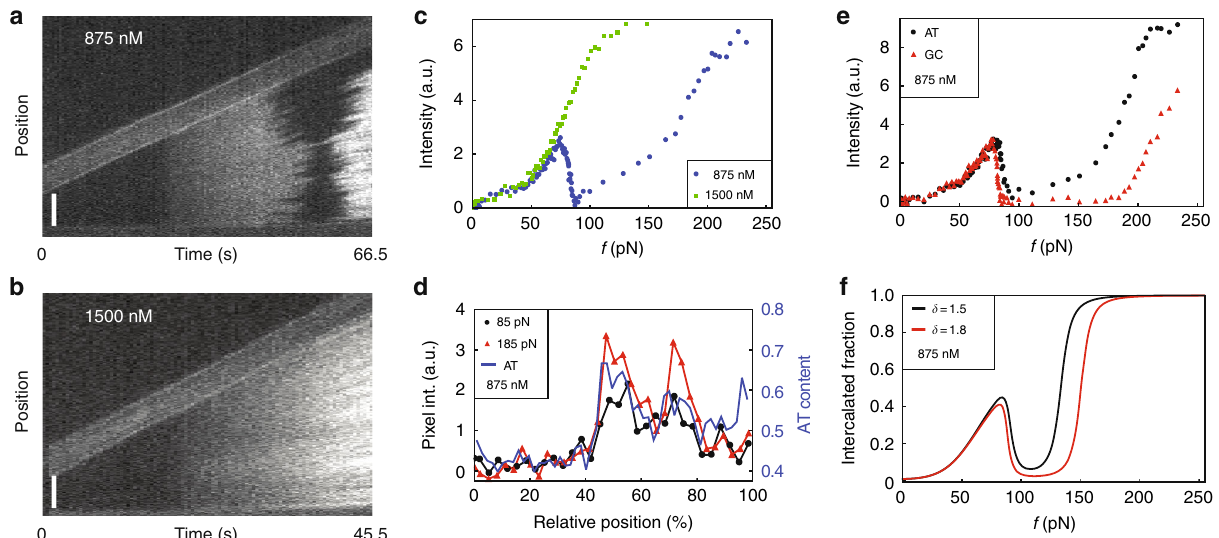
Fig. 3 Force- fl uorescence experiments con fi rm the existence of hyperstretched (HS-) DNA. a , b Kymographs of stretching experiments in the presence of 875 and 1500 nM of the intercalator YO-PRO (length of the scale bar is 5 μ m; here the bright ~5 µ m wide band shows one bead moving upwards to stretch the DNA). c Integrated fl uorescence intensities as a function of force for 875 nM YO-PRO (blue circles) and 1500 nM YO-PRO (green squares). Intensities in different kymographs have been scaled to facilitate comparison. d The local fl uorescence intensity at stretching forces 85 and 185 pN and 875 nM YO- PRO concentration is strongly correlated with the local AT content of the DNA. e Intensity as a function of force for AT- and GC-dominated regions at 875 nM YO-PRO. f A difference in the free energy penalty for neighbouring intercalated base pairs δ qualitatively explains the difference between AT- and GC- dominated regions seen in e . For discussion, we refer to the main beyond 0.58 nm per bp can only be explained by the presence of HS-DNA and not by potential peeling 29 .